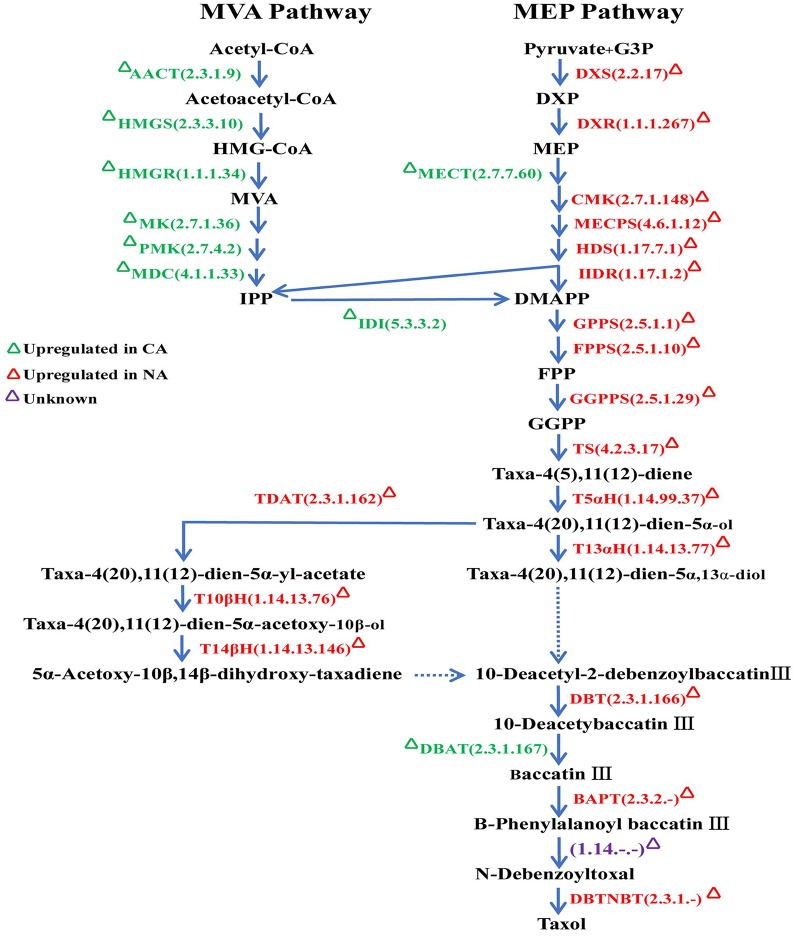
Schematic representation of the taxol biosynthetic pathway. Enzymes were marked according to their specific expression in CA and NA. AACT, acetyl-CoA C-acetyltransferase; HMGS, hydroxymethylglutaryl-CoA synthase; HMGR, hydroxymethylglutaryl-CoA reductase; MK, mevalonate kinase; PMK, phosphomevalonate kinase; MDC, diphosphomevalonate decarboxylase; DXS, 1-deoxy-D-xylulose-5-phosphate synthase; DXR, 1-deoxy-D-xylulose-5-phosphate reductoisomerase; MECT, 2-C-methyl-D-erythritol 4-phosphate cytidylyltransferase; CMK, 4-diphosphocytidyl-2-C-methyl-D-erythritol kinase; MECPS, 2-C-methyl-D-erythritol 2,4-cyclodiphosphate synthase; HDS, (E)-4-hydroxy-3-methylbut-2-enyl-diphosphate synthase; HDR, 4-hydroxy-3-methylbut-2-en-1-yl diphosphate reductase; IDI, isopentenyl-diphosphate Delta-isomerase; GPPS, geranyl diphosphate synthase; FPPS, farnesyl diphosphate synthase; GGPPS, geranylgeranyl diphosphate synthase; TS, taxadiene synthase; T5αH (CYP725A4), taxadiene 5alpha-hydroxylase; T13αH (CYP725A2), taxane 13-alpha-hydroxylase; TDAT, taxadien-5-alpha-ol O-acetyltransferas; T10βH (CYP725A1), taxane 10-beta-hydroxylase; T14βH (CYP725A3), taxoid 14beta-hydroxylase; DBT, 2-alpha-hydroxytaxane 2-O-benzoyltransferase; DBAT, 10-deacetylbaccatinIII 10-O-acetyltransferase; BAPT, Baccatin III amino phenylpropanoyl-13-O-transferase; DBTNBT, 3′-N-debenzoyl-2′-deoxytaxol N-benzoyl transferase.